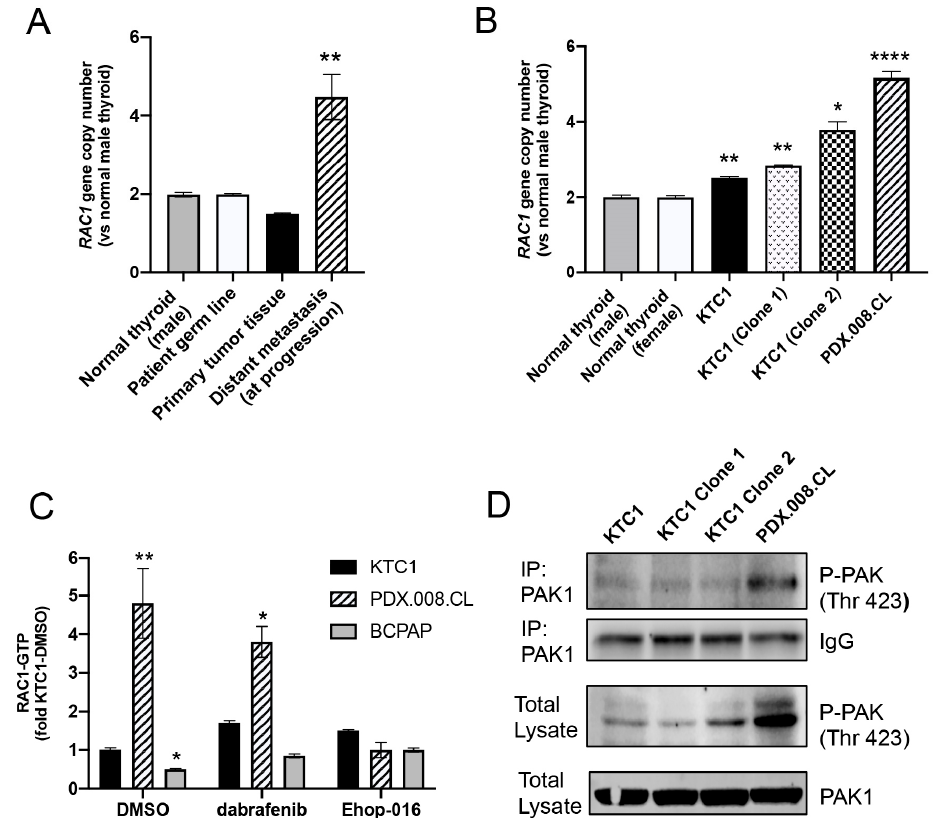
Figure 5. RAC1 copy numbers in patient samples and cell lines and RAC1/PAK1 activity. ( A ) RAC1 gene copy number in the PTC patient tumor samples (primary tumor and metastatic lesion) indicating polyploidy of RAC1 in the metastatic sample at progression in comparison with normal male thyroid, patient germline control and primary tumor tissue. An average of 5 copies of RAC1 was found in the metastatic sample at progression. ( n = 3, ** = p <0.005). ( B ) RAC1 gene copy number in unsynchronized KTC1 and PDX.008.CL cells in comparison to male and female normal thyroid controls. An average of five copies were detected in the PDX.008.CL cells, and 2–4 copies in the KTC1 clones. ( n = 3, * = p <0.05, ** = p < 0.005, **** = p < 0.0001). ( C ) Total activity of RAC1 protein in different cell types was measured by quantifying its binding to GTP. The activity of RAC1 was significantly elevated in PDX.008.CL cells in comparison to the other thyroid cancer cell types KTC1 and BCPAP. Further, RAC1 activity in PDX.008.CL cells was reduced down to levels comparable to the other cell types by using EHop-016. ( n = 3, * = p < 0.05, ** = p < 0.01). ( D ) Increased activity of PAK1 in PDX.008.CL cells was detected after immunoprecipitation using a PAK1 antibody followed by Western blot detection of phospho-PAK1 at Thr423. PAK1 activity was also higher in KTC1 clone 2 cells than in KTC1 clone 1 and KTC1 control cells (total